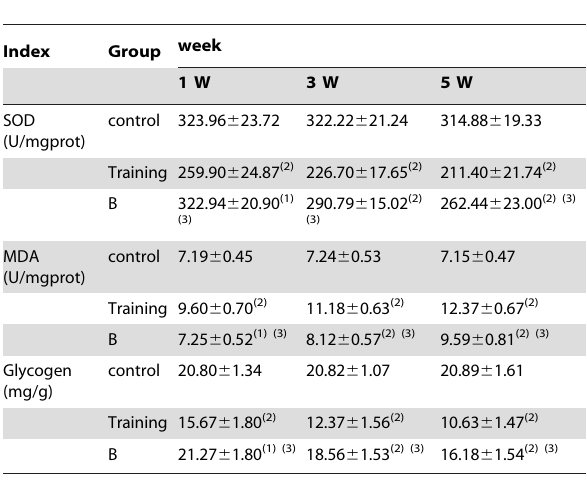
Table 3. Effect of pulse current on SOD, MDA and glycogen contents of liver.